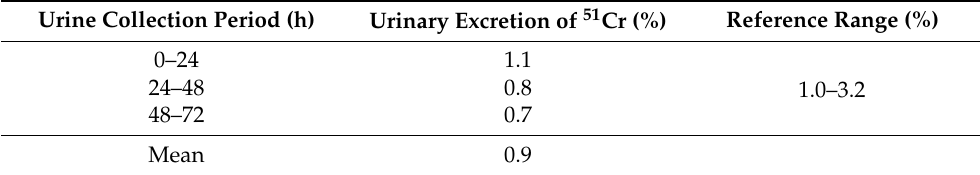
Figure 3. In vivo survival of EE-TP in Patient 1. The first administered dose of EE-TP (4 U/kg body weight) was labelled with 51 Cr and the survival characteristics of the loaded erythrocytes assessed by following the disappearance of label from the circulation. Table 2. Urinary excretion of 51 Cr after infusion of EE-TP in Patient